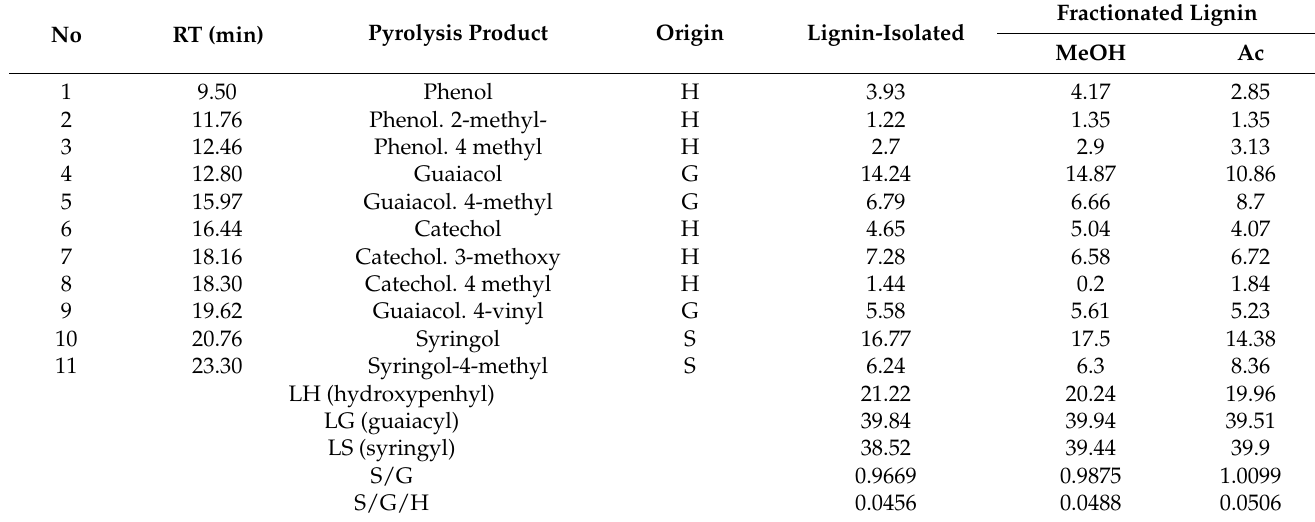
Table 4. Pyrolysis products of lignin assessed by Py-GCMS.